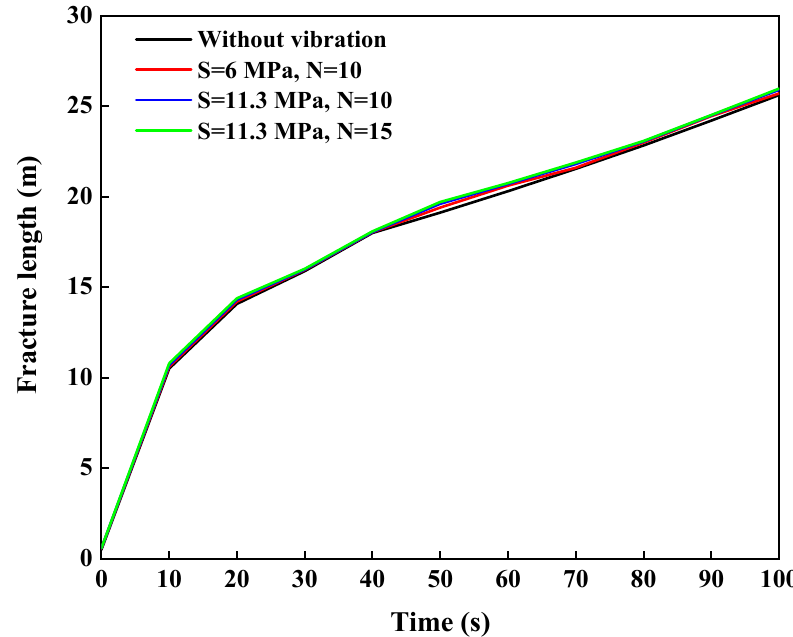
Figure 11. Fracture length as a function of time profiles for different vibration cyclic loads.